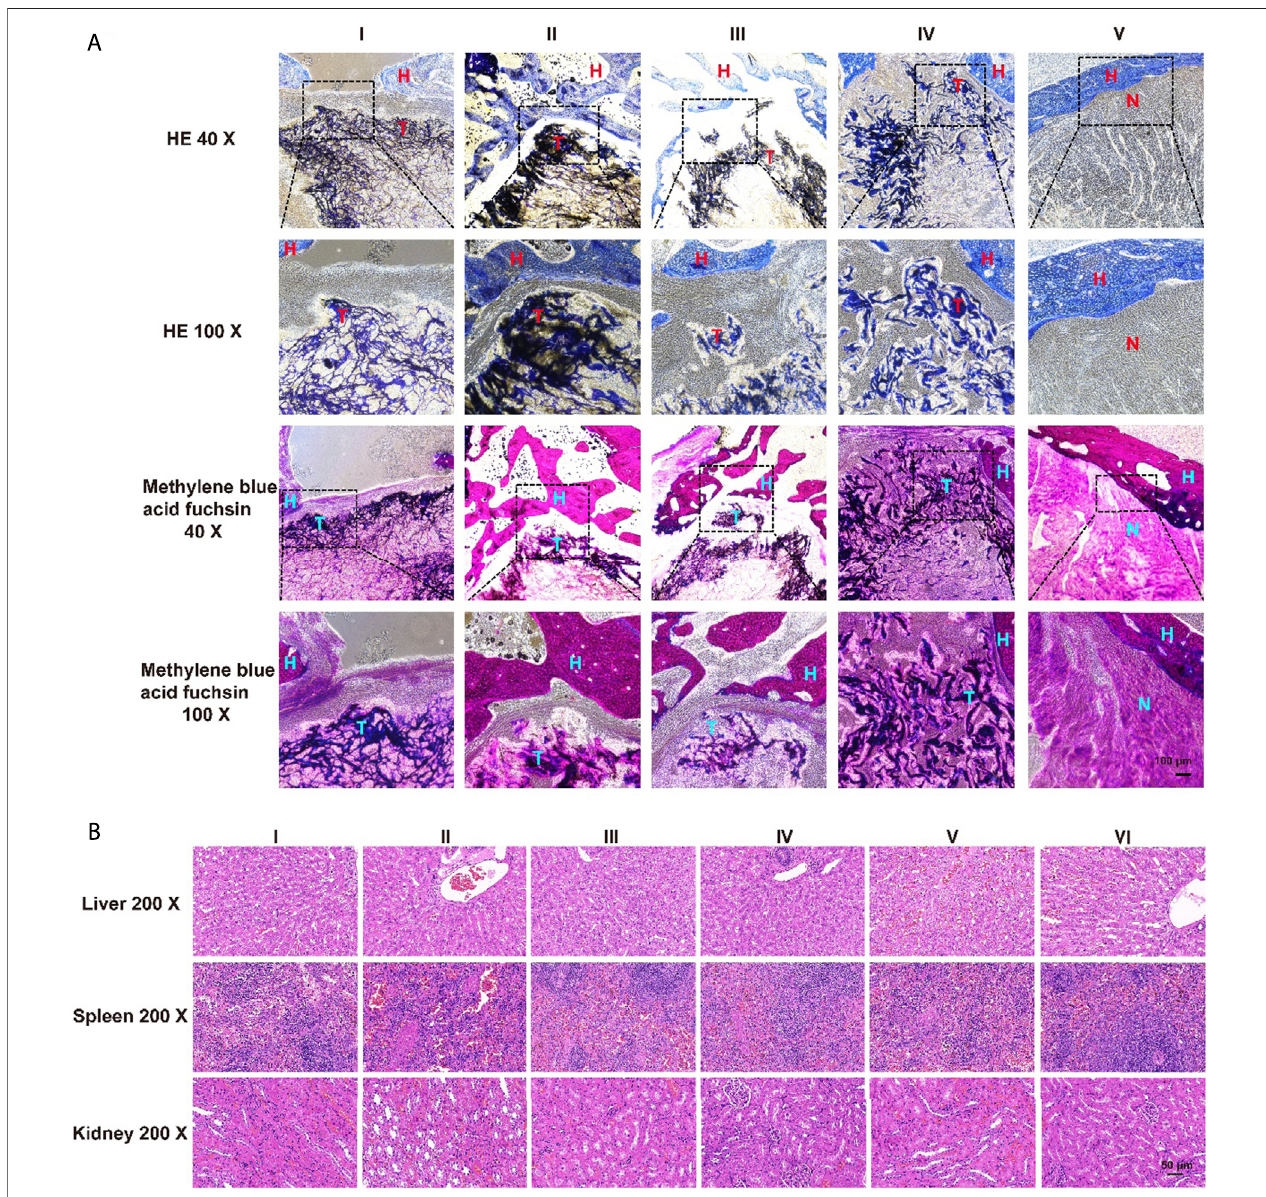
FIGURE 9 | The results of HE and methylene blue acid fuchsin staining and safety monitoring. (A) There were obvious bone formation and new bone formation at the junction between the aerogel scaffold and host bone. The ability of the aerogel scaffold carrying SOST McAb + SDF-1 to promote new bone formation was signi fi cantly higher than that of other groups (B) . Results of HE staining of visceral organs. 12 weeks after the operation, no pathological abnormality was found in the liver,spleen,and kidneyoftherabbitsineach experimentalgroup (I-IV) compared withthegroup without scaffoldunimplanted (V) and theoftheunoperatedgroup (VI). Group I aerogel scaffold without loading drugs, Group II aerogel scaffold loaded with SOST McAb, Group III aerogel scaffold loaded with SDF-1, Group IV aerogel scaffoldloadedwithSOSTMcAb+SDF-1,GroupVthecontrolgroupwithoutscaffoldimplant,GroupVIrabbitwithoutsurgery.Hmarkedasthehostbone,Tmarkedas the aerogel scaffold, N marked as the tunnel with granulation tissue. HE, hematoxylin-eosin staining.